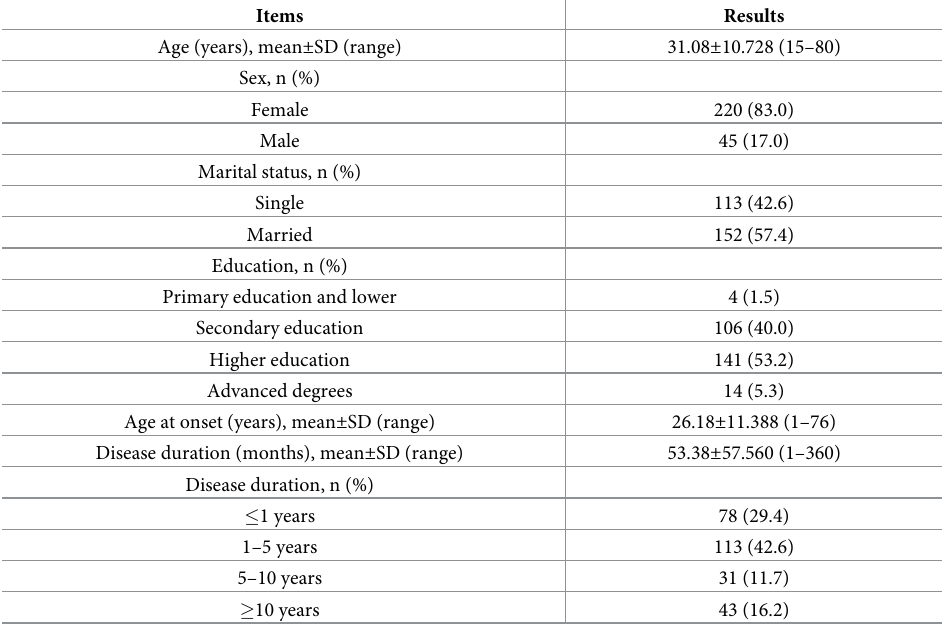
Table 1. Epidemiological data of rosacea